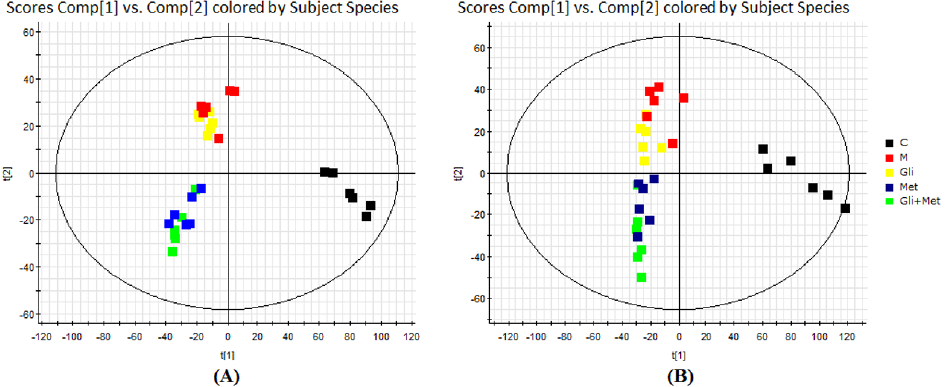
Figure 3. Partial least squares discriminant analysis (PLS-DA) score plots derived from the ultrahigh-pressure liquid chromatography/electrospray ionization quadrupole time-of-flight mass spectrometry (UHPLC/ESI-QTOF-MS) profiles of rat urine samples in negative ( A ) and positive ( B ) ionization modes. C: control group; M: model group; Gli: glimepiride treatment group; Met: metformin treatment group; Gli + Met: their combination treatment group.